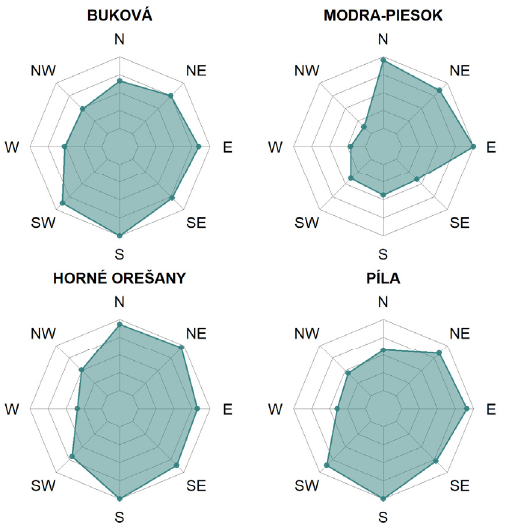
Figure 8. Radar plots for the summarization of the aspect of the catchment slopes.